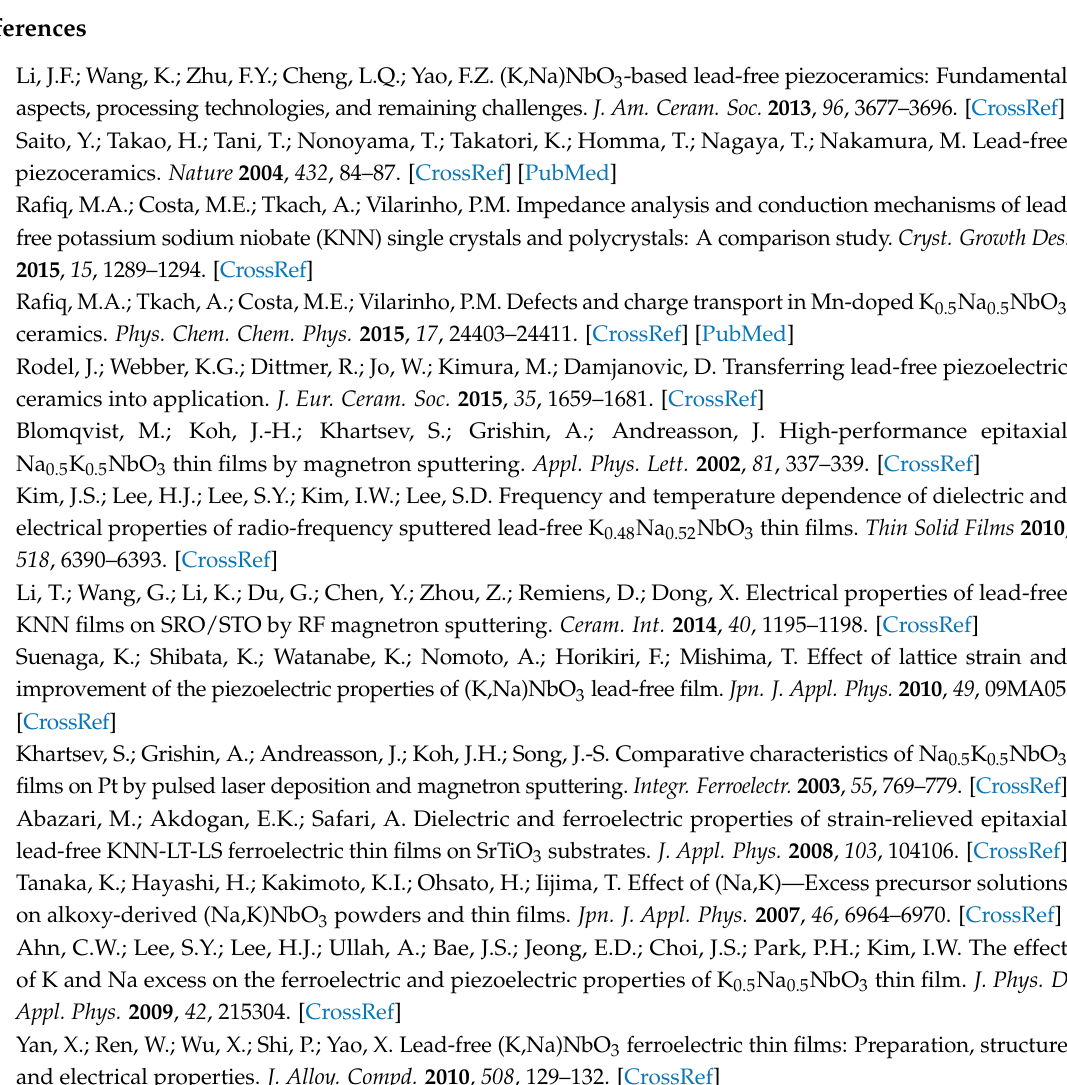
Figure S1: polarization ( P )-electric field ( E ) loops of KNN films deposited on Pt/SrTiO 3 (solid line) and Pt/TiO 2 /SiO 2 /Si substrates (dash line) measured at room temperature and 50 Hz under electric field up to 45 (a), 60 (b) and 75 kV/cm (c), Figure S2: topography (a), out-of-plane PFM signal (b), cross-section profile of topography and PFM amplitude (c) and local piezoelectric hysteresis loops (d) of KNN thin films deposited on Pt/SrTiO 3 substrates. No out-of-plane piezoresponse could be obtained for KNN films on Pt/TiO 2 /SiO 2 /Si substrates, Figure S3: strain ( d ψ − d 0 )/ d 0 of KNN films on Pt/TiO 2 /SiO 2 /Si (open circles) and Pt/SrTiO 3 substrates (solid squares) as a function of sin 2 ψ together with linear fits used for stress calculations at room